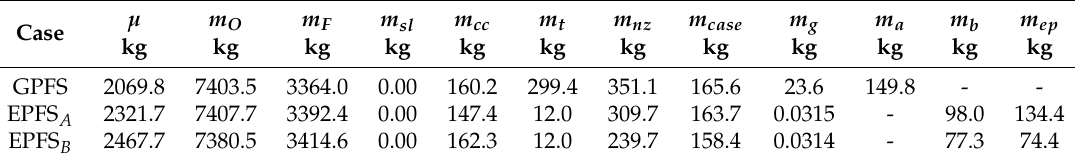
Table 6. Mass budget comparison.